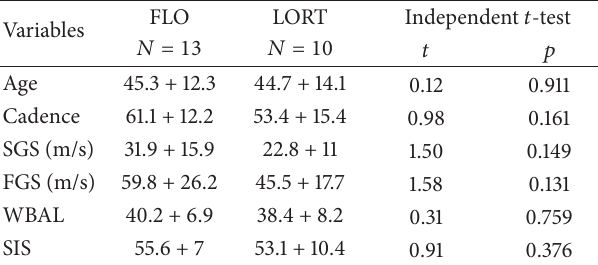
Table 2: Between-group comparison of the dependent variable at baseline.